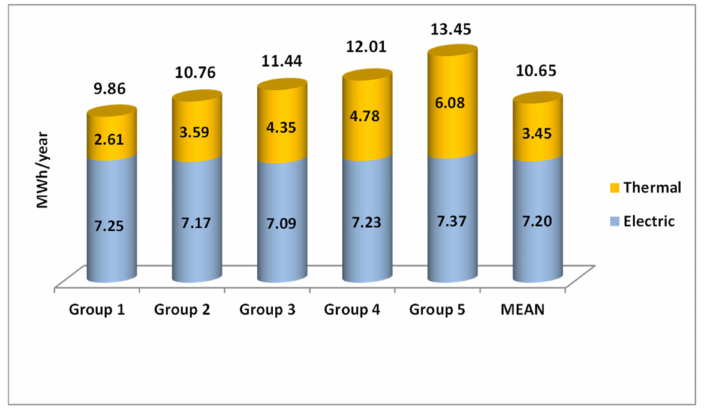
Figure 8. Thermal, electric, and total mean energy consumptions per household by group of cities without the influence of